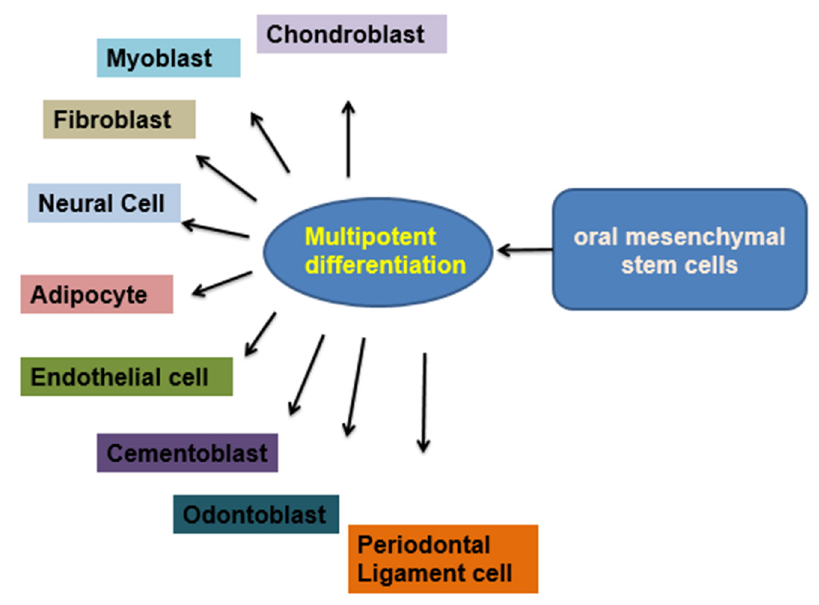
Figure 5. Potential for differentiation of oral mesenchymal stem cells.